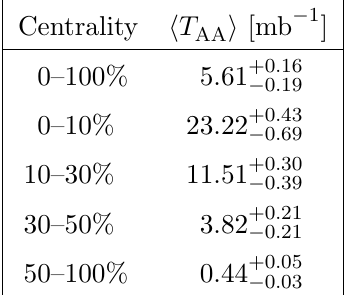
Table 1 . Average numbers of the nuclear overlap function ( h T various centrality ranges used in this